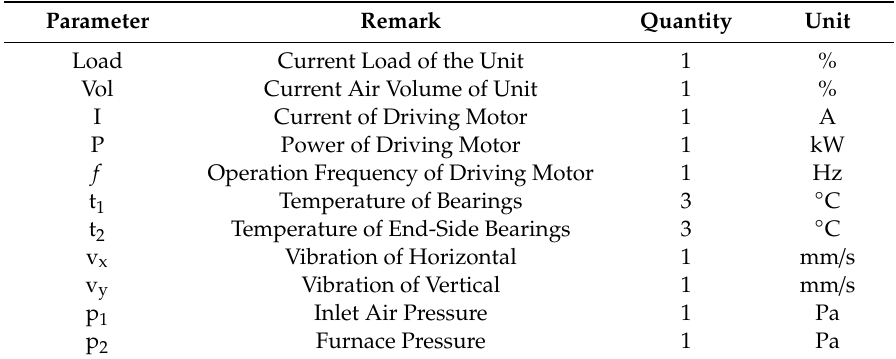
Table 1. Parameter of blower